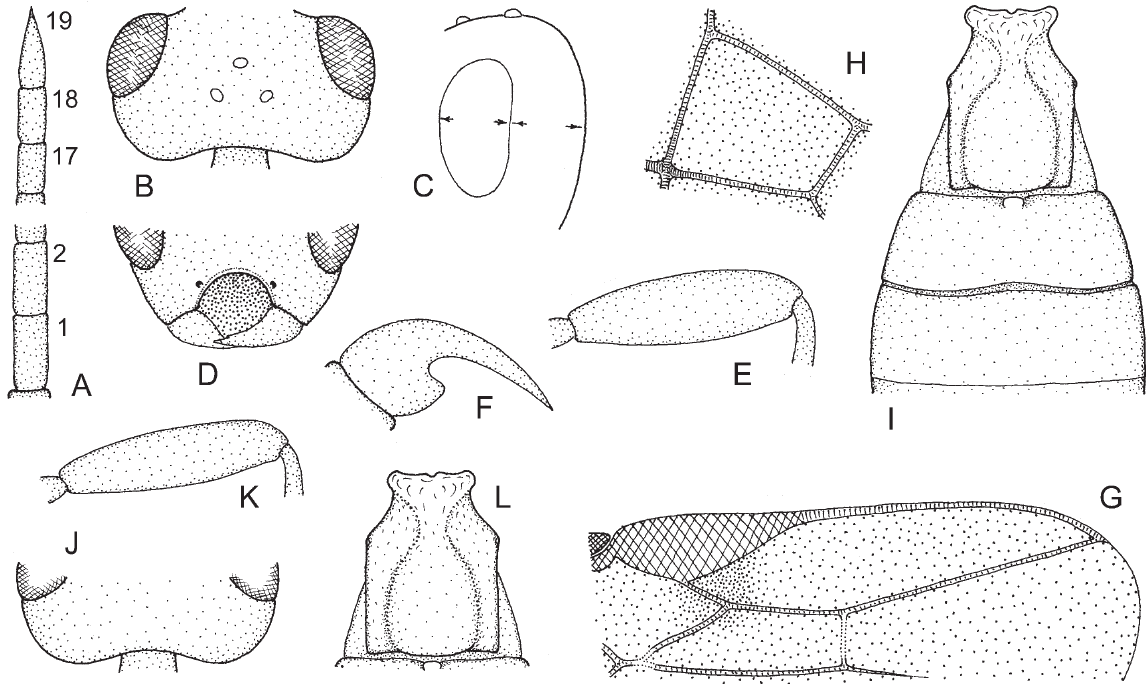
Fig. 31. Bracon ( Glabrobracon ) parvulus Wesmael, 1838 (A-I: ♀ holotype, , J-K: ♀ / ♂, L: ♀). A . Flagellomeres 1-2 and 17-19. B . Head in dorsal view. C . Head in lateral view. D . Head in frontal view. E . Hind femur. F . Claw. G . Distal part of right forewing. H . First discal cell of right forewing. I . Tergites 1-3. J . Hind half of head in dorsal view. K . Hind femur. L . First